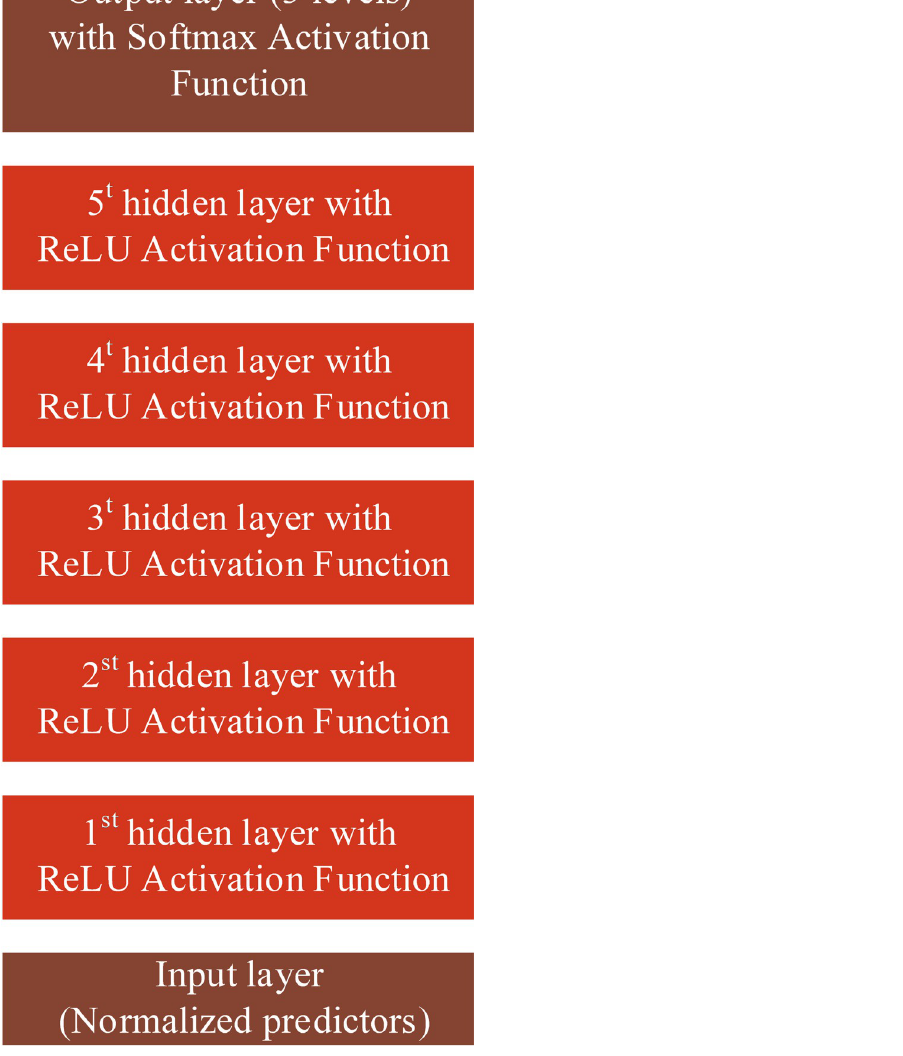
a G-mean value of 89.3%. The worst class recall value of the RF algorithm without prior over- sampling is only 34.4% in comparison to the corresponding value of 90.3% in the up-sampled model. More on the impacts of the preprocessing scheme on the quality of the final forecasts, the recall values of the high and low severity classes (KA and BC) increase when the SMOTE is carried out on the data, and see a decrease after the application of the RF feature selection. The